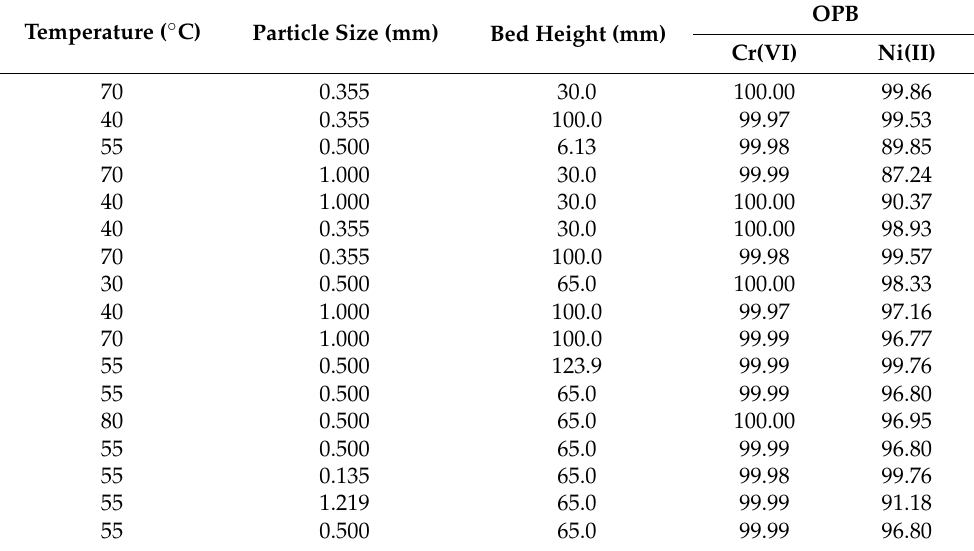
Table 2. Cr(VI) and Ni(II) removal efficiency over OPB in a continuous system.